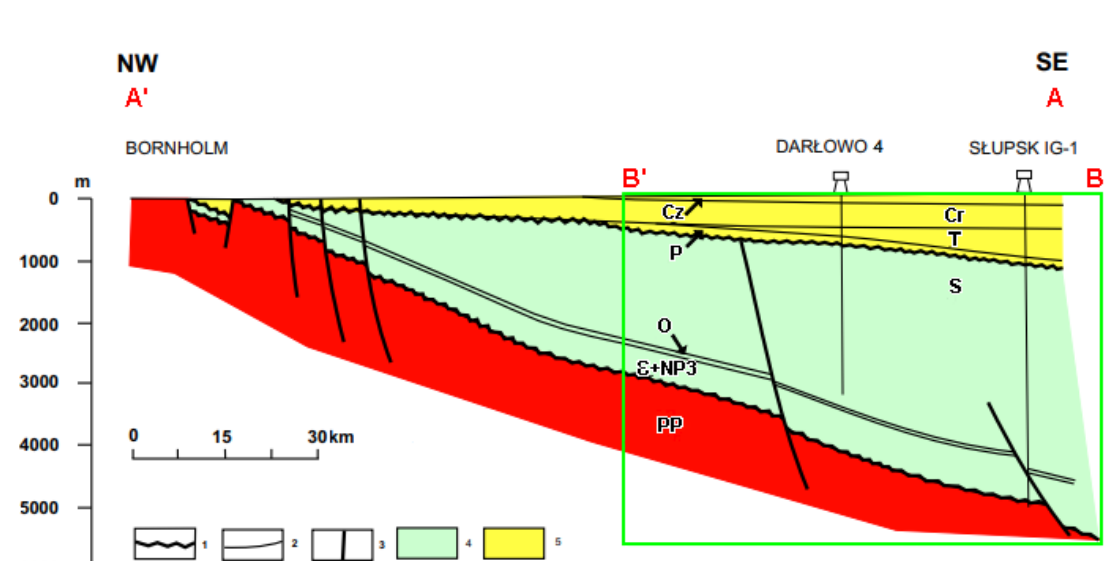
Figure 3. Geological and tectonic settings of A’-A cross-section Bornholm-Słupsk IG-1 well shown in Figure 2 (after [13]). Explanations: 1—unconformities, 2—stratigraphic boundaries, 3—faults, 4—Caledonian tectonic units, 5—Alpine tectonic units, PP—Paleoproterozoic, Є +NP3—Cambrian+Upper Neoproterozoic, O—Ordovician, S—Silurian, P—Permian, T— Triassic, Cr—Cretaceous, Cz—Cenozoic. Light green rectangle—part of A’-A cross-section included in the 2D modeling (B’-B cross-section).